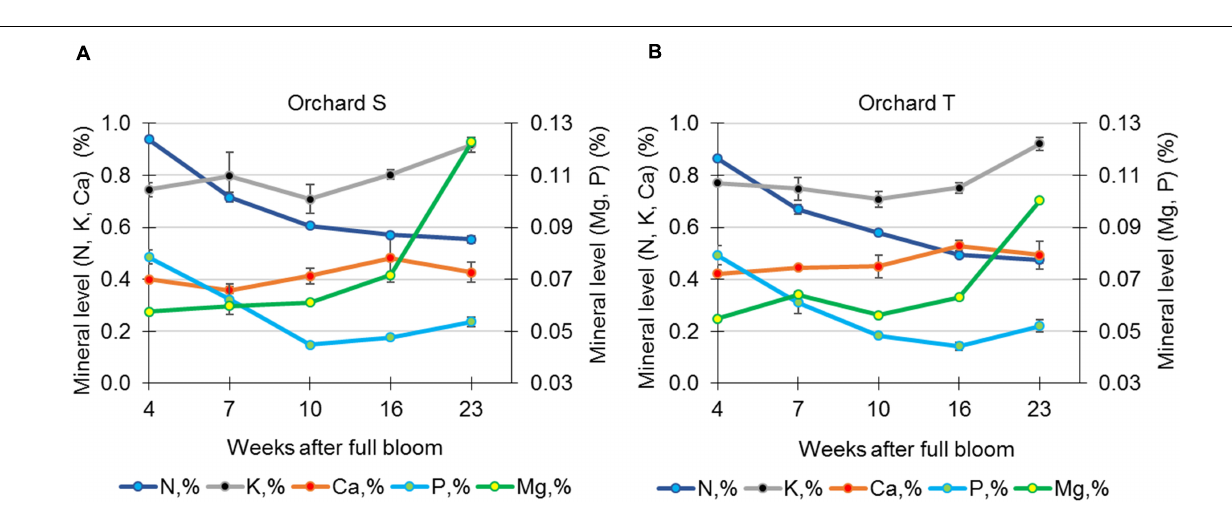
FIGURE 6 | Determination of minerals in pomegranate skin during the growth season of 2017. Data represent fruit from orchards S (A) and T (B) . The concentrations of N, P, K, Ca, and Mg are given as percentage of skin tissue dry weight. Values are averages of three replicate fruits ±